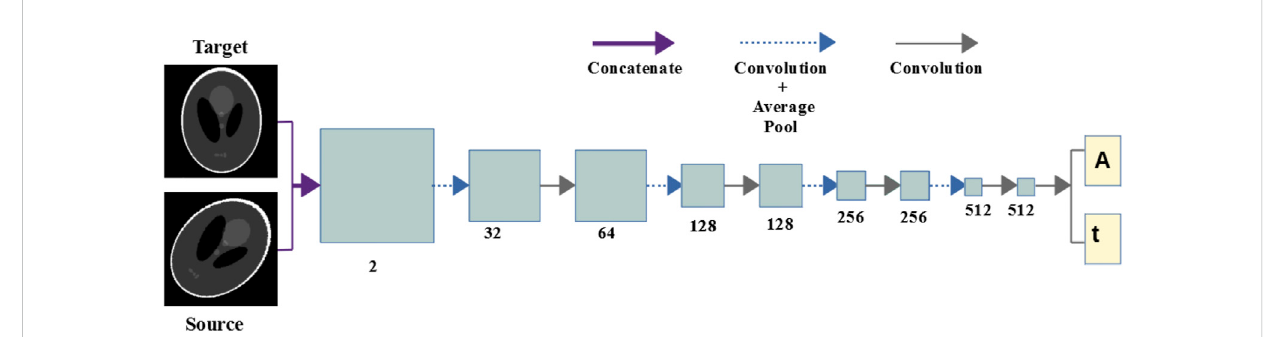
FIGURE 2 Convolutional neural network: The network consists of a series of convolutional and pooling layers after selected convolution operations. Two convolution operations are carried out at the fi nal layer to output the transform matrix and the translational